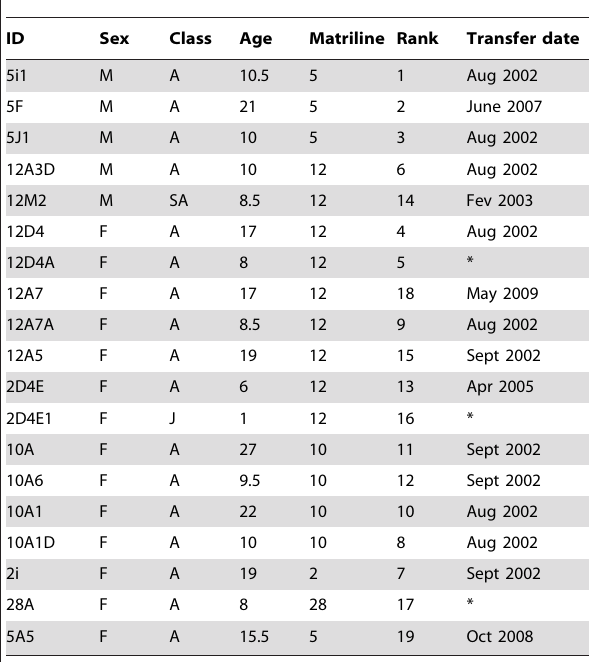
Table 1. Individual details about sex (M = male, F = female), class (A= adult, SA = sub-adult, J= juvenile), age, matriline, dominance rank and transfer date of the study